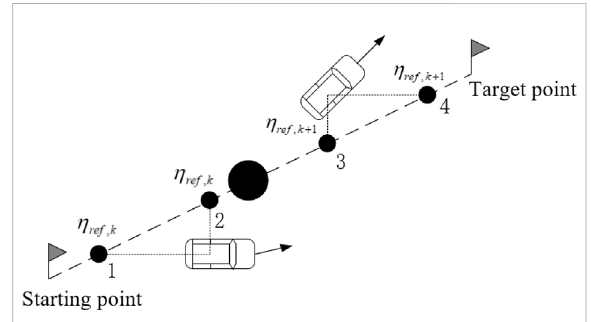
The method of fi nding the starting reference track